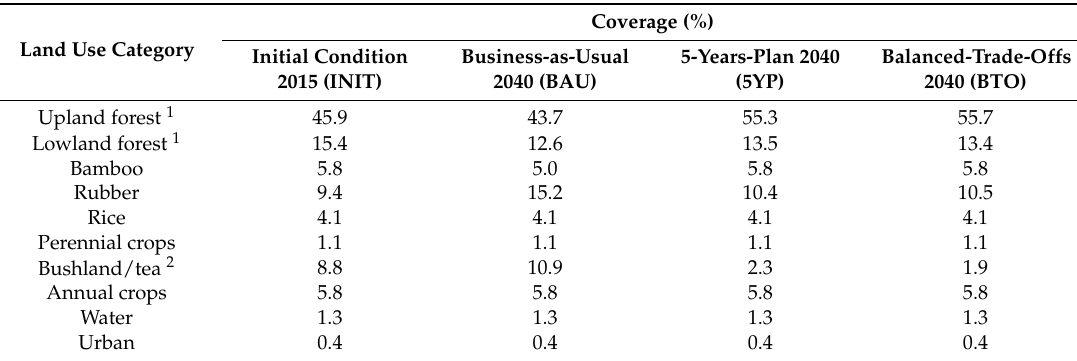
Table 1. Percent coverage of land use categories in Nabanhe Reserve (271 km 2 ) for each scenario derived from Thellmann et al.